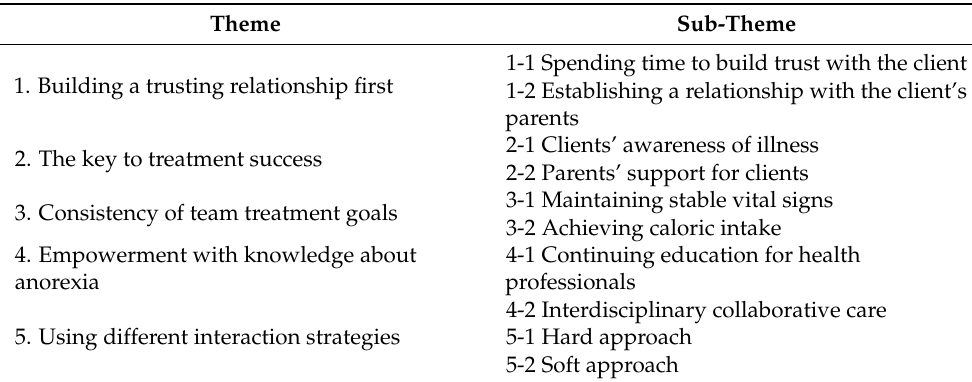
Table 1. Themes and